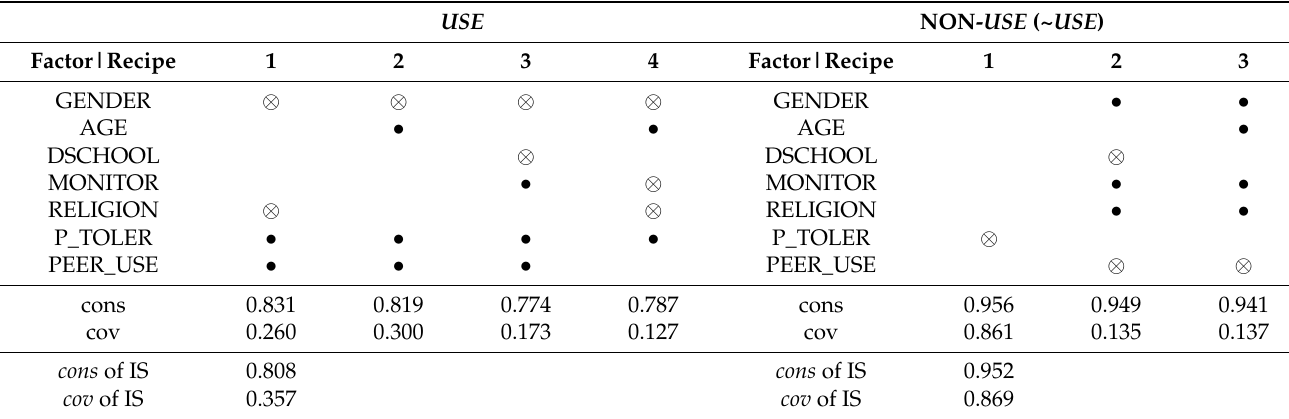
Table 6. fsQCA solutions of USE and ~ USE